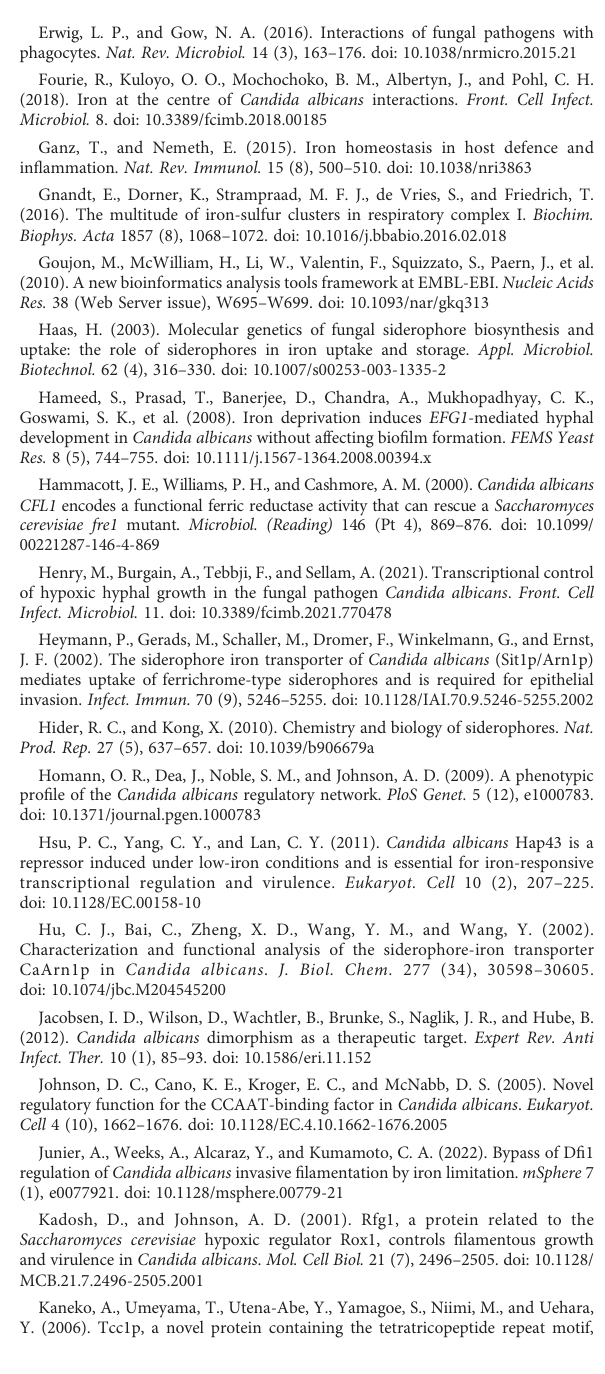
Associations arebased on networks illustrated in Witchley et al. (2021)and ChIP-chip/ChIP-Seq data from previous publications summarized in DataSheet_1 Transcriptional Circuits Regulating Developmental Processes in Candida albicans taken from Rodriguez et al. (2020). Red edges indicate activation, black edges repression and grey edges indicate that no change in expression was observed. Of note, Irf1 only binds to negative regulators of commensalism.